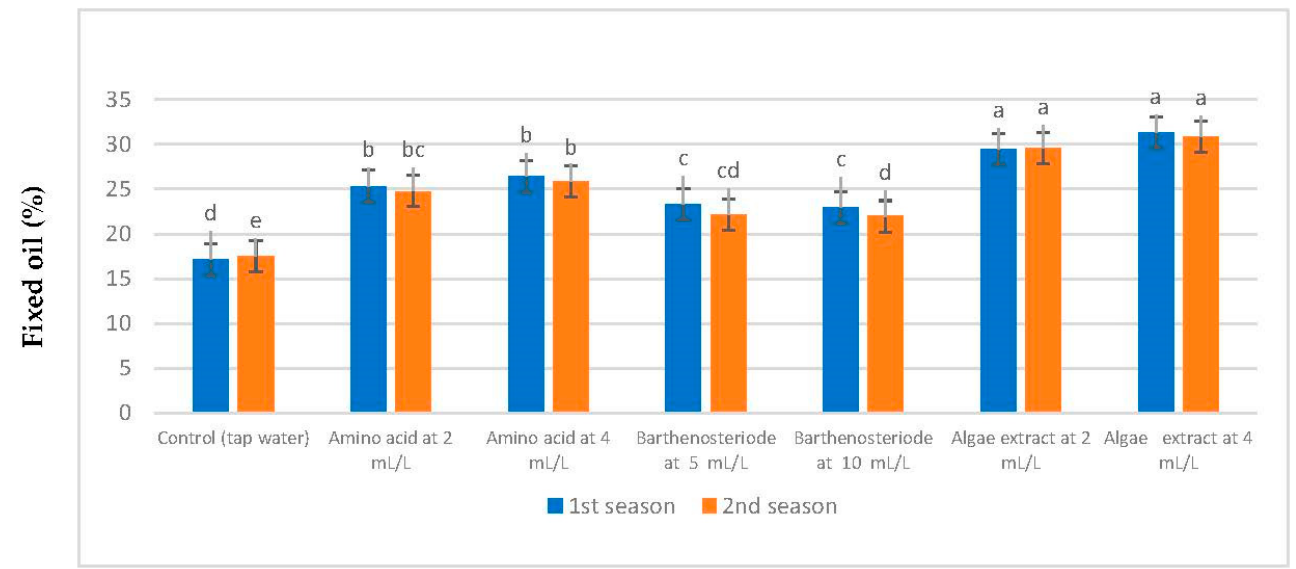
Figure 11. Effect of various bio-stimulants treatments on fixed oil (%) of chia ( Salvia hispanica L.) plant during the 2019–2020 and 2020–2021 seasons. For the same column, means followed by the same letter are not statistically different, according to the Tukey multiple range test.